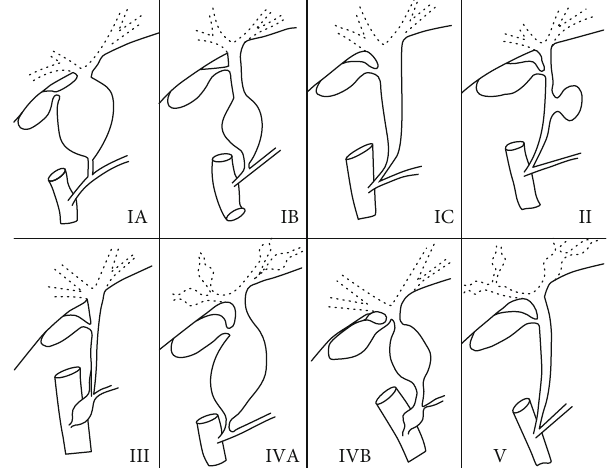
Figure 1: Todani classi fi cation of cystic dilation of the bile